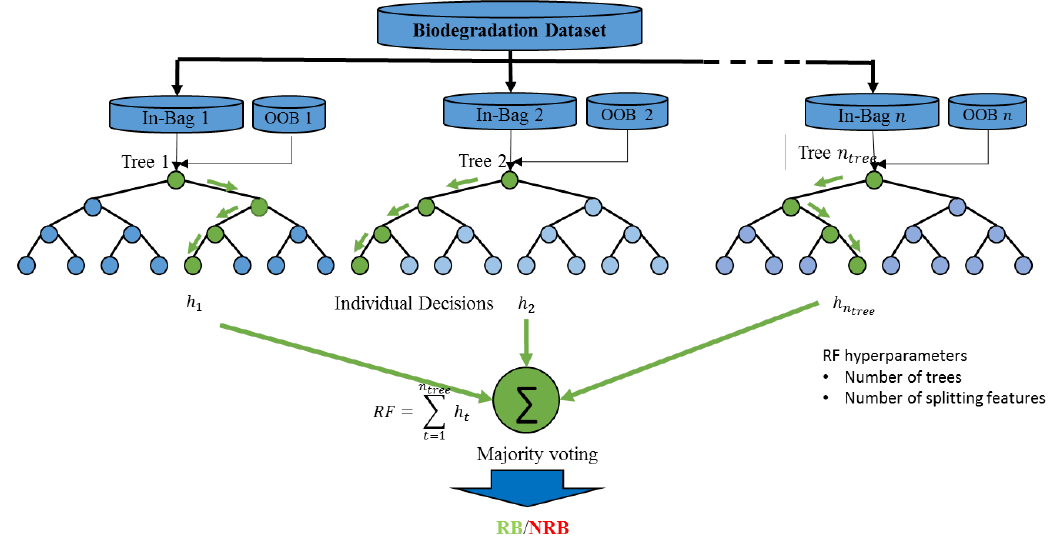
Figure 2. Structure of random forest.